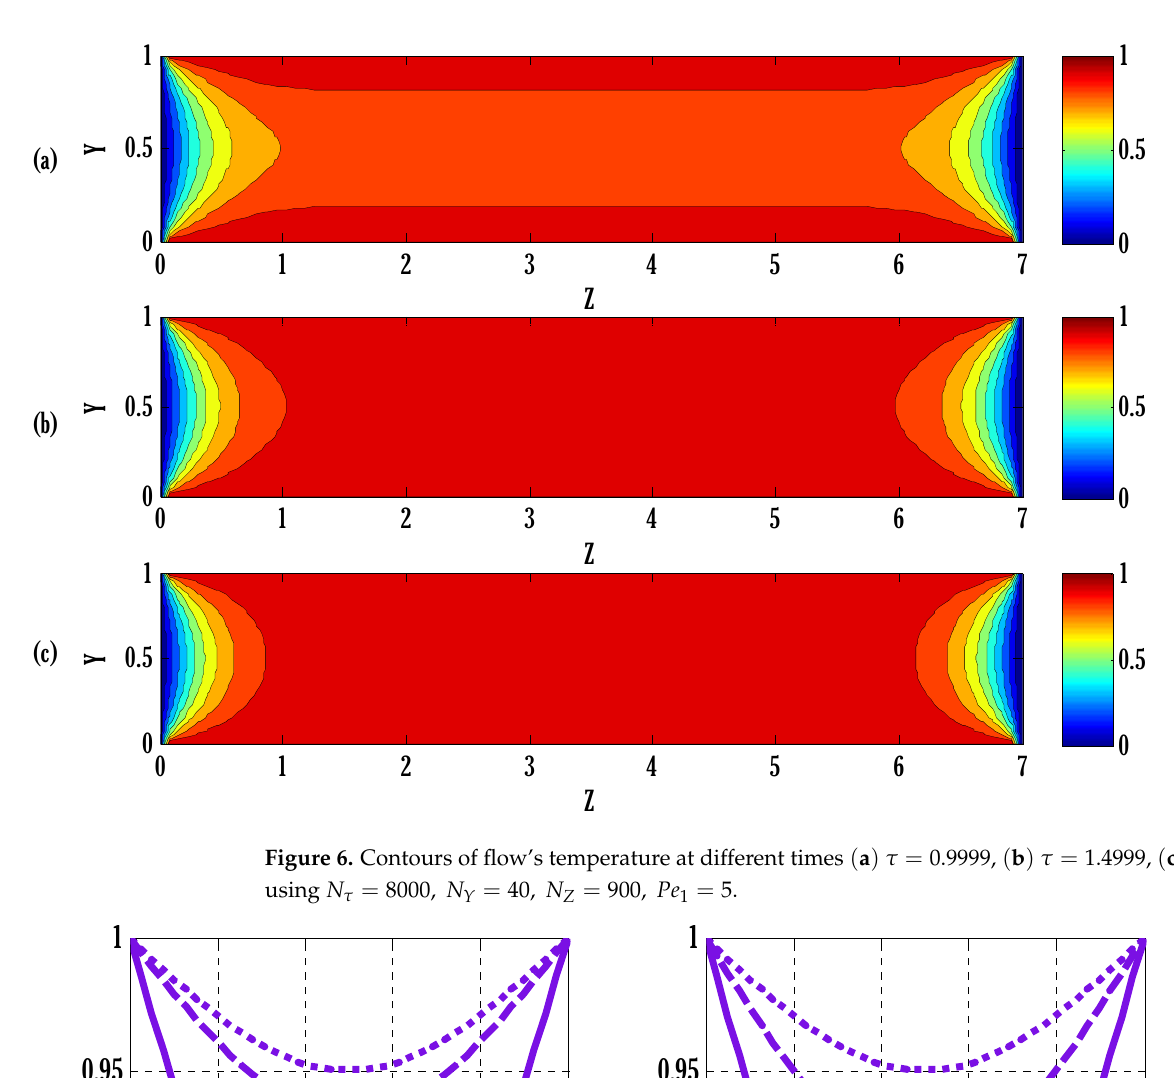
Figure 5. Impact of thermal Péclet number on contours of flow’s temperature at ((cid:1801)) (cid:1842)(cid:1857) (cid:2869) = 10 , ((cid:1802)) (cid:1842)(cid:1857) ((cid:1803)) (cid:1842)(cid:1857) (cid:2869) = 15 , (cid:2869) = 20 using (cid:1840) (cid:3099) = 3500,(cid:1840) (cid:3026) = 40,(cid:1840) (cid:3027) = 900,(cid:1872) (cid:3033) = 1 .